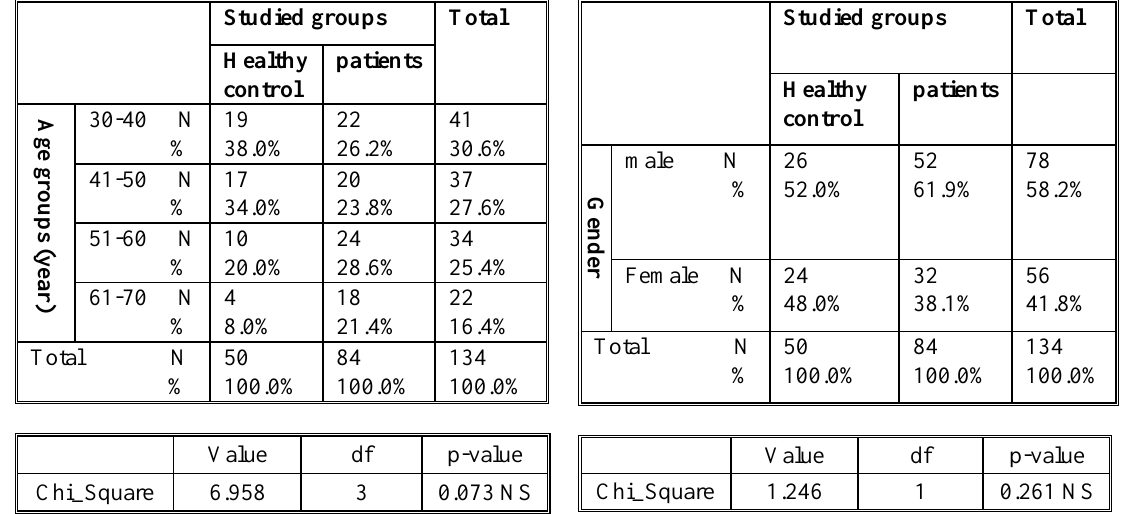
Table 1: Distribution of studied groups according to age / Year .